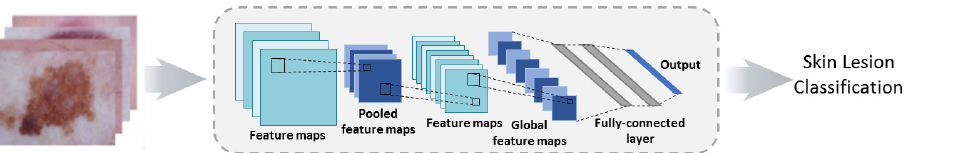
Figure 5. DL-based skin lesion